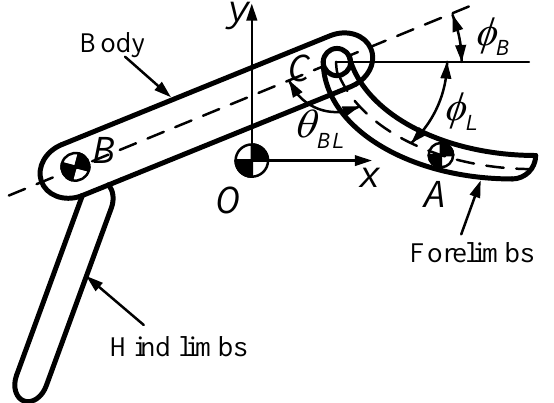
Figure 19. Schematic of the robot after takeoff for dynamics modeling of pitching adjustment.